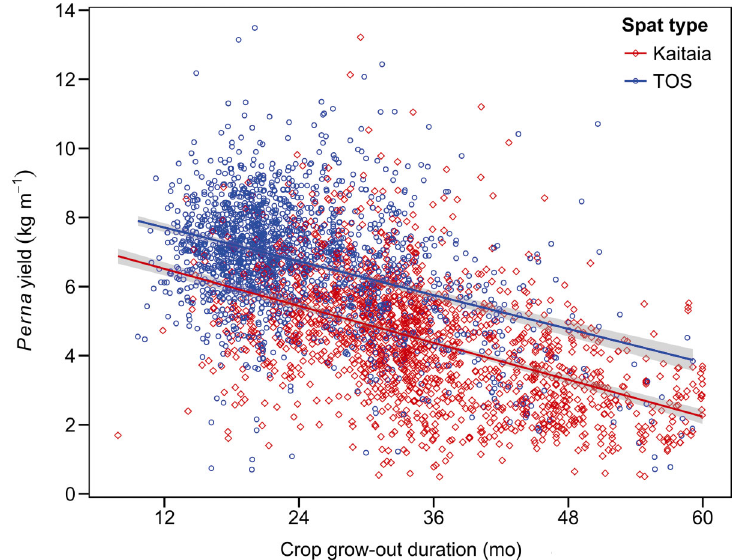
Fig. 3. Perna canaliculus yield per crop in relation to grow-out duration and spat type (Kaitaia and top-of-the-South; TOS). Linear regression lines are bounded with 95% confidence intervals (grey